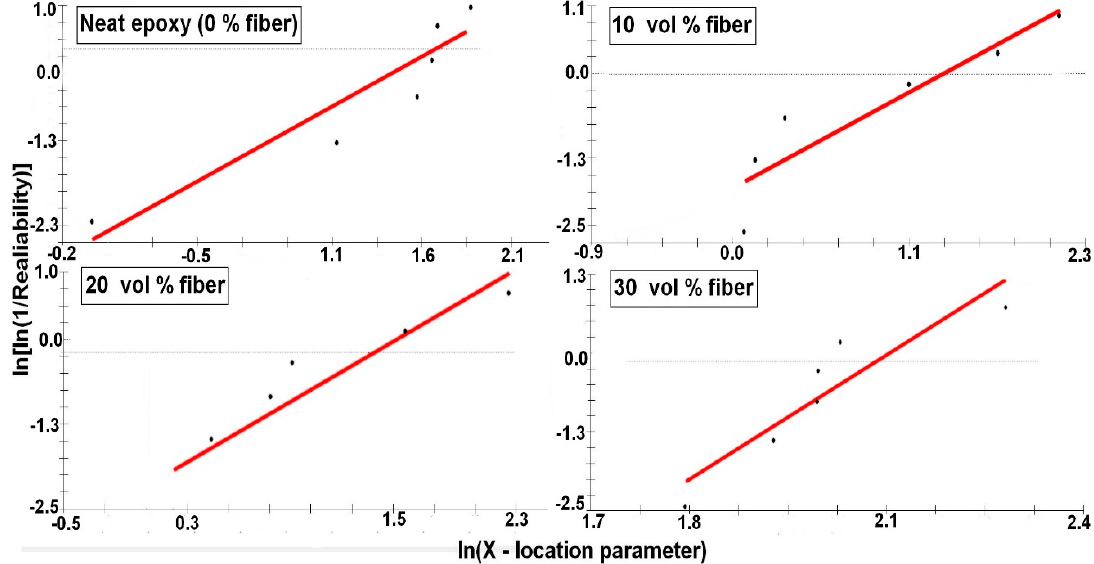
Figure 7. Tensile strength Weibull plots for the epoxy composites reinforced with different volume fractions of caranan fiber.